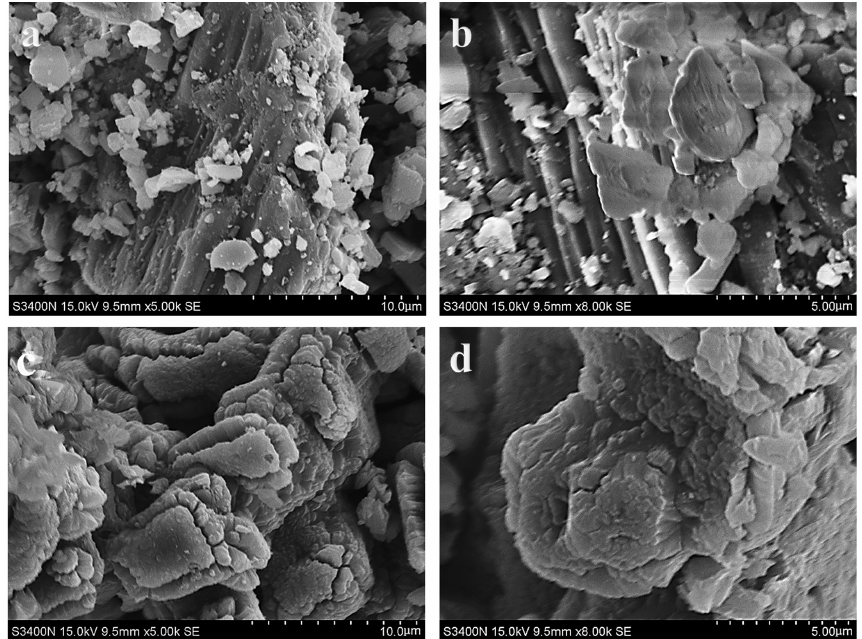
Figure 4. SEM images of ( a , b ) USP and ( c , d ) OCSP.